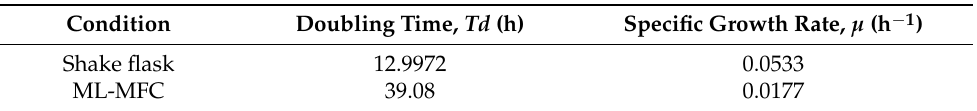
Table 6. Kinetics growth profile of BS growth using chicken manure supplemented with sludge in shake flask and in ML-MFC